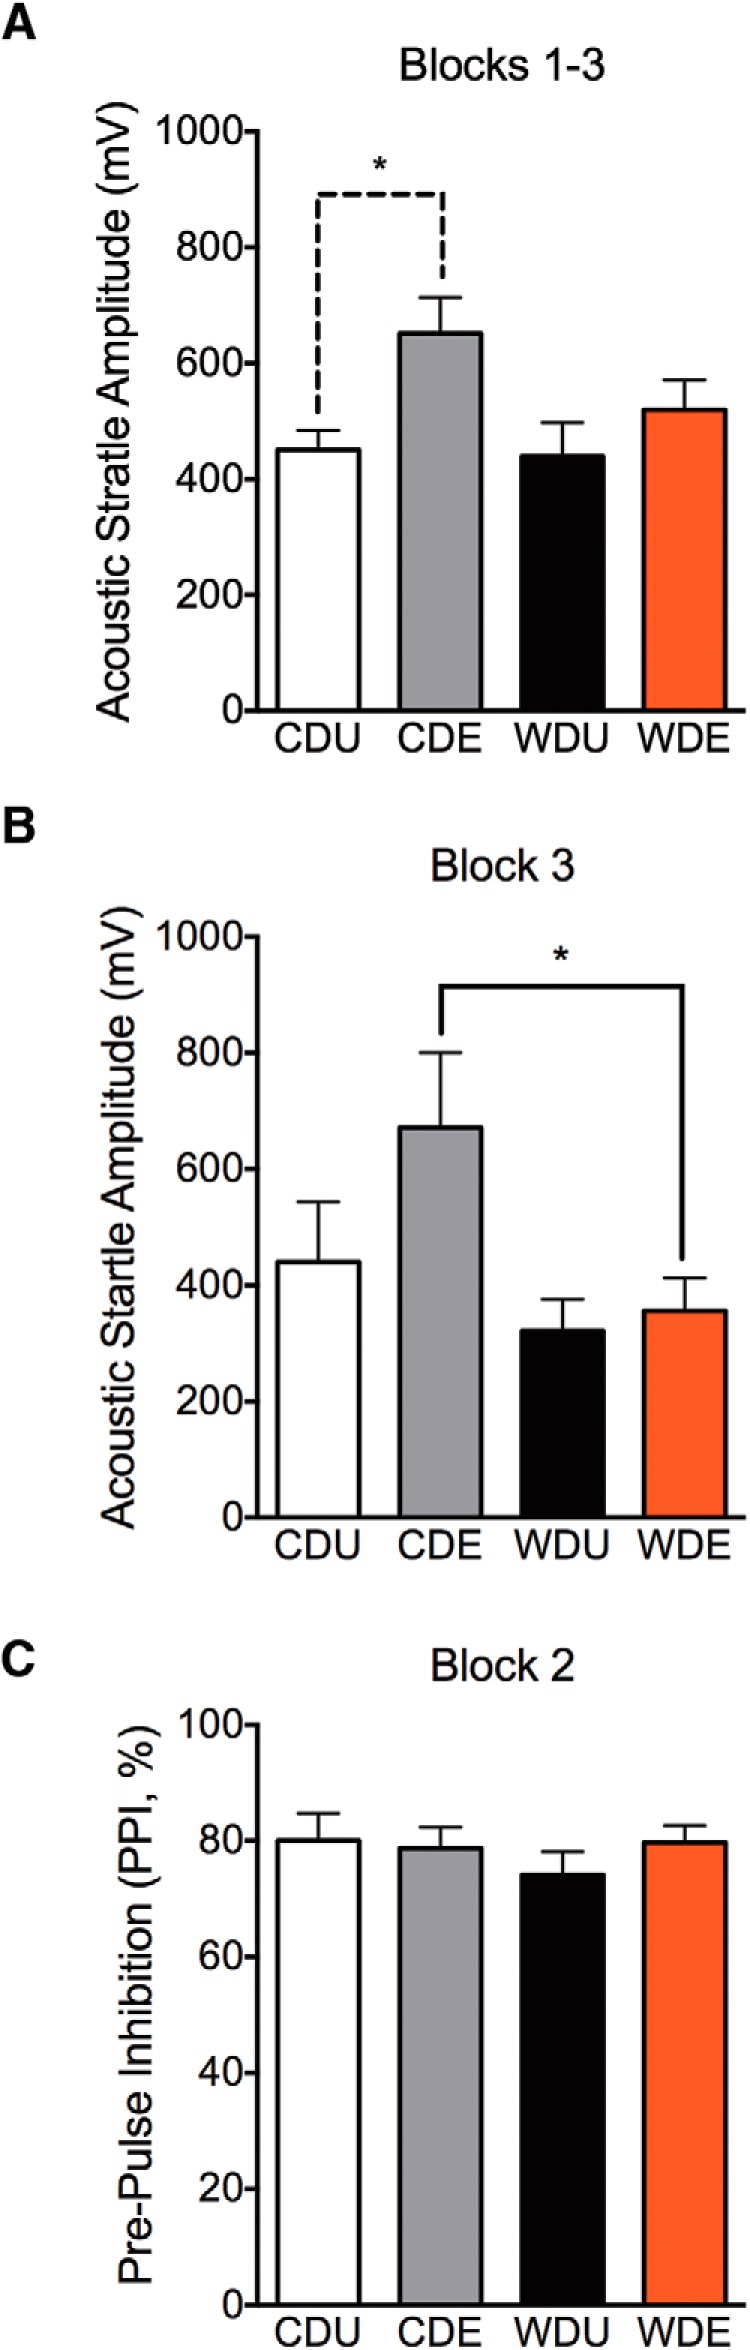
WD reduces traumatic stress-induced startle responses. A, We found that the maximum ASR amplitude increased at 1 week post-PS (PS: F(1,25) = 5.43, p = 0.028; diet: F(1,25) = 1.41, p = 0.25; interactions: F(1,25) = 1.00, p = 0.33). Post hoc testing revealed a significant increase in ASR amplitude in CDE rats when compared with controls (p < 0.05). B, WDE rats exhibited reduced ASR responses during the last recording block when compared with CDE rats (diet: F(1,23) = 7.28, p = 0.013; Tukey’s adjusted for WDE vs CDE, p = 0.028). PS exposure (F(1,23) = 2.73, p = 0.11) or diet–PS exposure interactions (F(1,23) = 1.43, p = 0.24) did not affect the short-term habituation of the ASR. C, TW-ANOVA revealed no significant effect of diet (F(1,26) = 0.35, p = 0.56), PS (F(1,26) = 0.39, p = 0.54), or interaction between these factors (F(1,26) = 0.87, p = 0.36) on the PPI of the ASR. Data presented are presented as the mean ± SEM. Post hoc test, *p < 0.05, **p < 0.01, n = 10–23 rats.